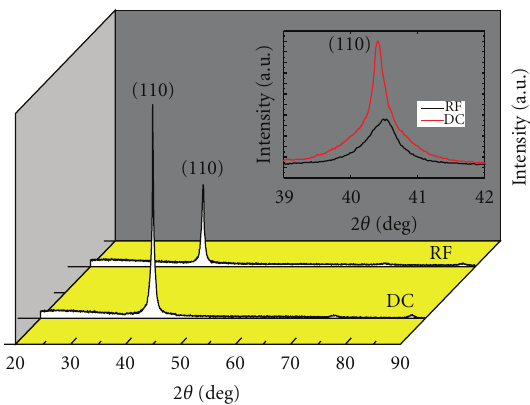
Figure 1: Typical XRD spectra of dc and rf magnetron sputtered molybdenum thin films at 10mTorr. (Inset: closeup of the (110) peak).